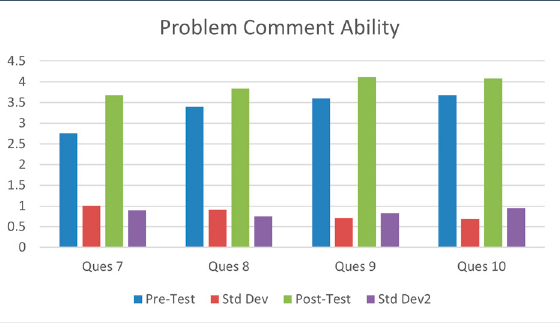
Figure 8. Students’ problem commenting ability in the previous test and the post-test.